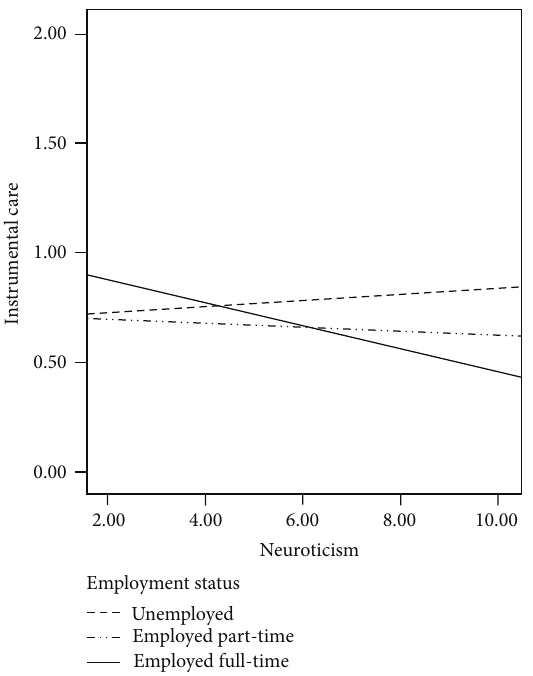
Figure 1: Interaction of employment status by neuroticism on willingness to provide instrumental care.